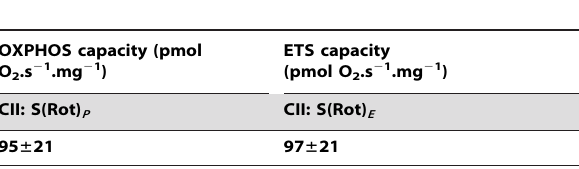
Table 6. Respiratory parameters from substrate-uncoupler- inhibitor titration protocol 3 (SUIT3) applied on equine permeabilized fibres of triceps brachii : OXPHOS and ETS capacities in trained horses ( N =15; trained horses matched with SUIT1 and SUIT2 protocols).